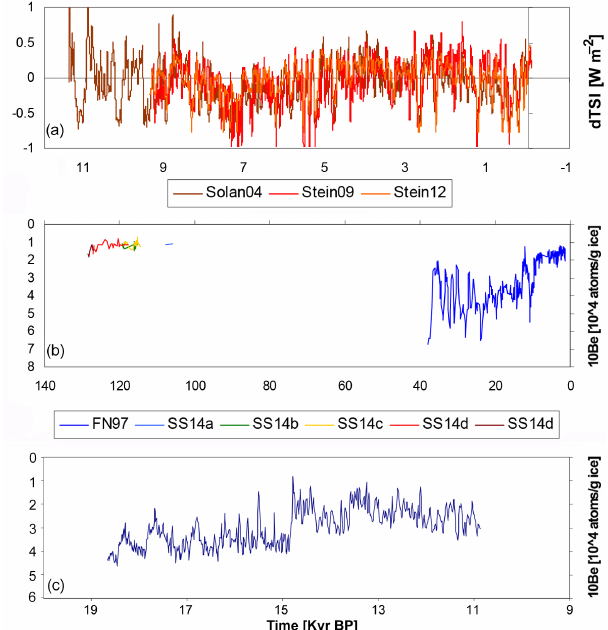
Figure 1. Solar-related signals. (a) Solar activity, TSI, recon- structed by S04, S09 and S12, after an intercalibration using the S09 record as a base. (b) 10 Be isotope concentration in polar ice cores during the past 130kyr (Finkel and Nishiizumi, 1997, FN97; Sturevik-Storm et al., 2014, SS14). (c) 10 Be isotope concentra- tion in Greenland ice cores during the period from 19 to 11kyrBP (Adolphi et al., 2014, A14). Please note that in all figures: as the 10 Be concentration varies inversely with solar activity, TSI, the beryllium scales are inverted, and thus the upper parts in these scales indicate high TSI levels.